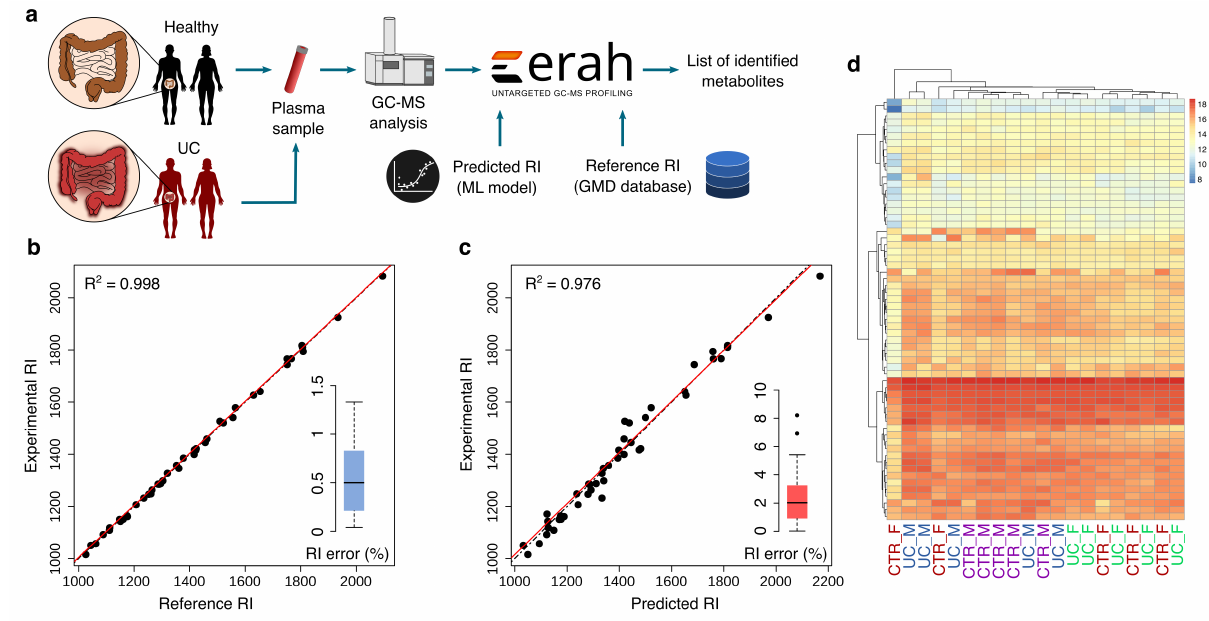
Figure 5. Application of RT/RI prediction in plasma samples from patients with ulcerative colitis (UC). ( a ) Workflow graphical representation. ( b ) Experimental vs. reference RI and ( c ) experimental vs. predicted RI of the identified metabolites. ( d ) Heat-map and sample hierarchical clustering of identified metabolites in plasma samples (M for male, F for female, CTR for control and UC for ulcerative